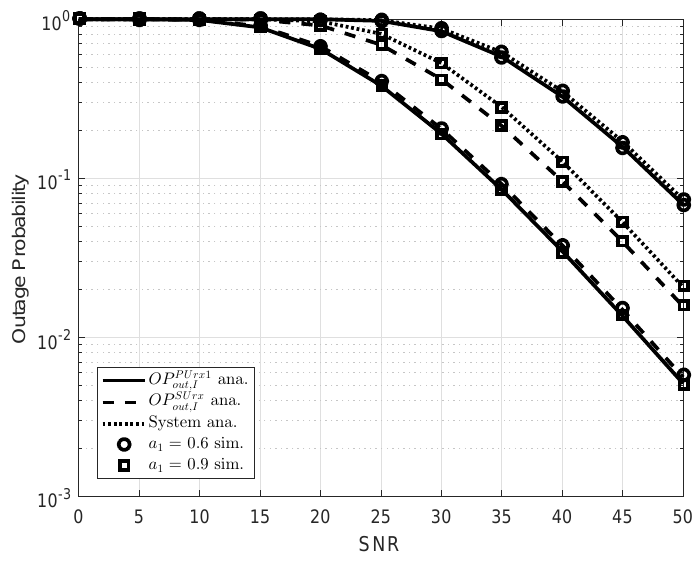
Figure 4. Scheme 1: PUrx 1 and SUrx and overall outage of system comparison with respect to varying both SNR and a 1 ( R PUrx 1 = R SUrx =